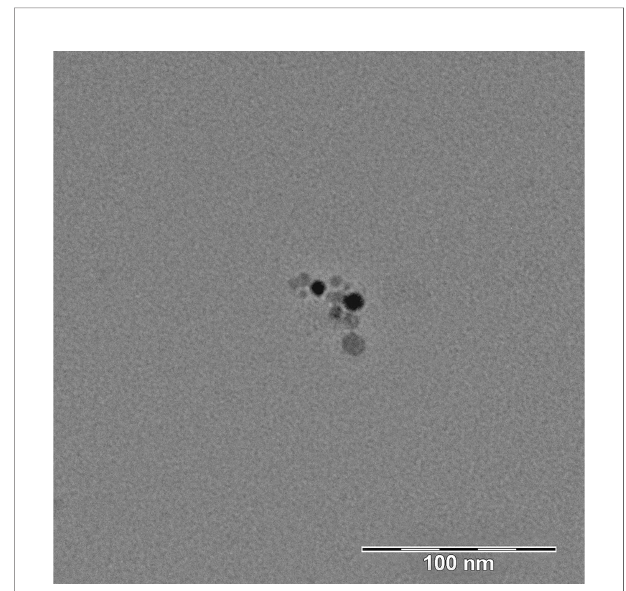
FIGURE 1 | Transmission electron micrograph of CuO NPs placed on the TEM grid. CuO NPs were measured in air inside the inhalation cage by Scanning Mobility Particle Sizer. They were composed of agglomerates of primary particles with a diameter of 3-11